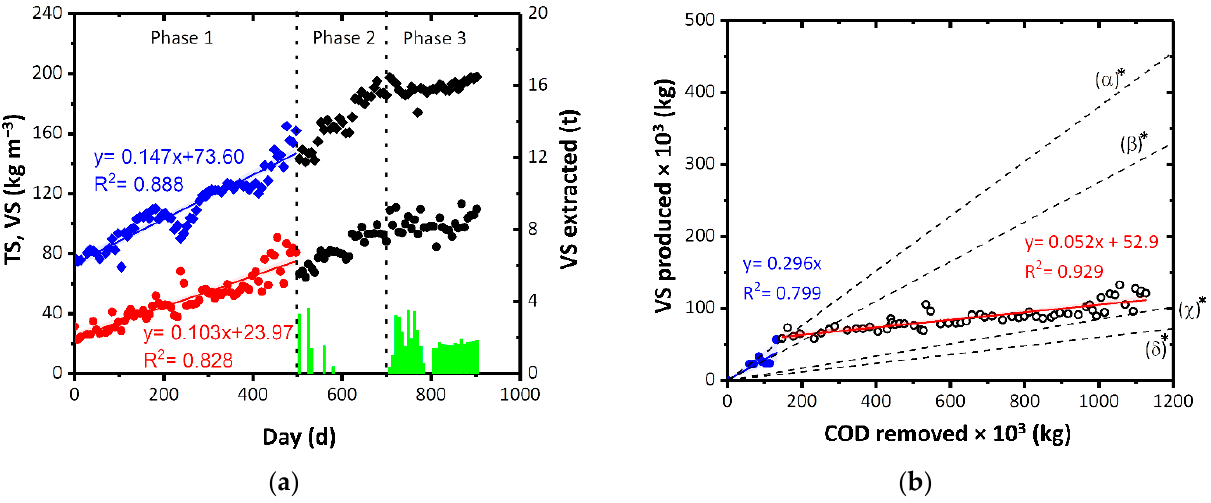
Figure 3. ( a ) Concentration of TS and VS in the biological reactor during the monitoring period and amount of VS extracted. ♦ indicates TS, • represents VS and green bars indicate VS extracted. ( b ) VS produced by the process as a function of COD removed and comparison with theoretical value of ( α ) CAS [61,62], ( β ) mesophilic MBR [63–65], ( γ ) thermophilic MBR [29], and ( δ ) value of the other full-scale ThMBR [35]. The specific productions of VS used as comparison were the mean values of those reported in the literature. Blue • represents VS in the start-up phase while ○ represents VS in the subsequent phase. The colored bands represent the 95% confidence interval of the linear fitting. * : values are expressed in kg VSS kg COD − 1 .